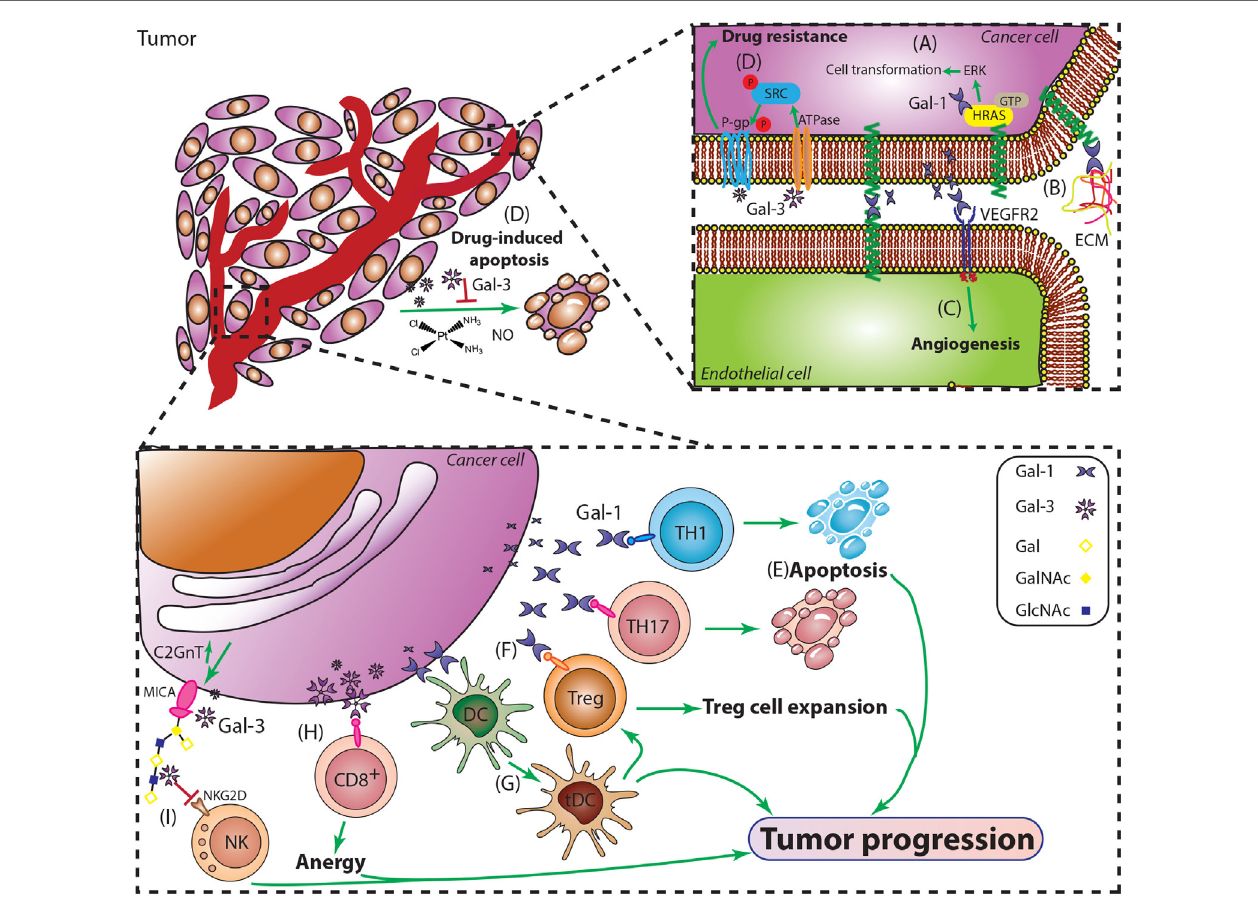
FiGURe 5 | Major roles of Gal-1 and Gal-3 during cancer progression . (A) Intracellular Gal-1 triggers activation of the H-Ras/ERK cascade leading to malignant transformation. (B) Gal-1 promotes adhesion of tumor cells to extracellular matrix and endothelial cells, critical steps during early stages of tumor invasion and metastasis. (C) Gal-1 induces tumor angiogenesis by engaging key proangiogenic pathways including VEGF-like signaling. (D) Resistance to apoptosis is essential for cancer cell survival and plays a role in tumor progression. Gal-3 suppresses apoptosis induced by cisplatin, nitric oxide (NO), or radiation, through interactions with P-gp and Na + /K + -ATPase, thus promoting tumor cell survival. (e) Gal-1 selectively deletes T H 1 and T H 17 cells and (G) promotes the differentiation of tolerogenic DCs (tDCs). (F) Gal-1 promotes expansion of CD4 + CD25 + Foxp3 + regulatory T cells (Tregs) and amplifies their immunosuppressive activity. (H) Gal-3 induces anergy of CD8 + T cells by distancing the TCR from CD8 molecules. (i) Gal-3 impairs NK cell function by inhibiting the interactions between the heavily O -glycosylated tumor-derived MICA and the NK cell activating receptor